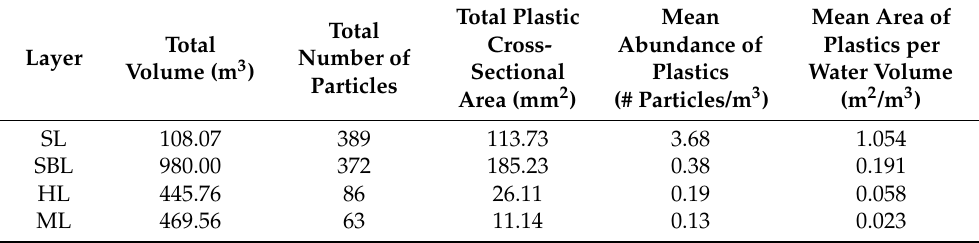
Table 1. Overview of microplastic particles distribution at different layers across the salinity gradient. Mean values were calculated in respect to 12 sampling events (three in each layer).